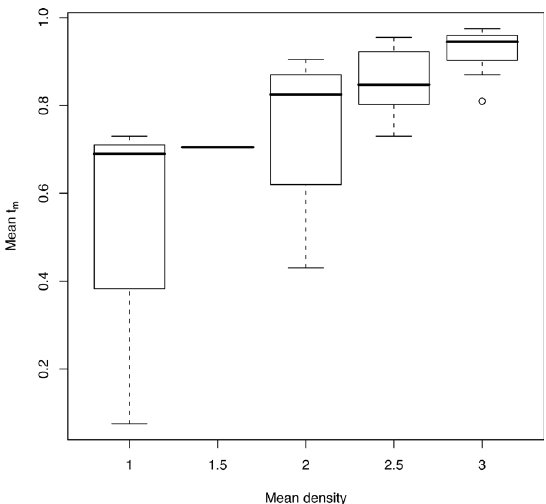
Fig. 5. Outcrossing rate variability versus density variability in Abies , Picea and Pinus species